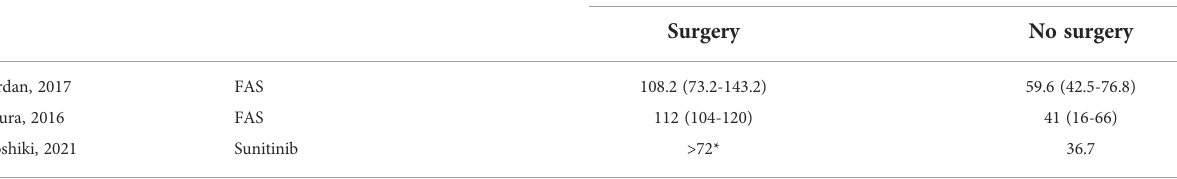
TABLE 4 Overall survival time between surgery group and no surgery group. Neoadjuvant